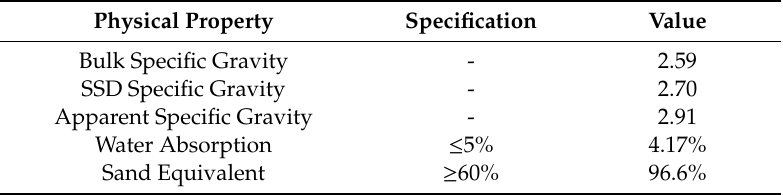
Table 2. Physical properties of fine aggregate.